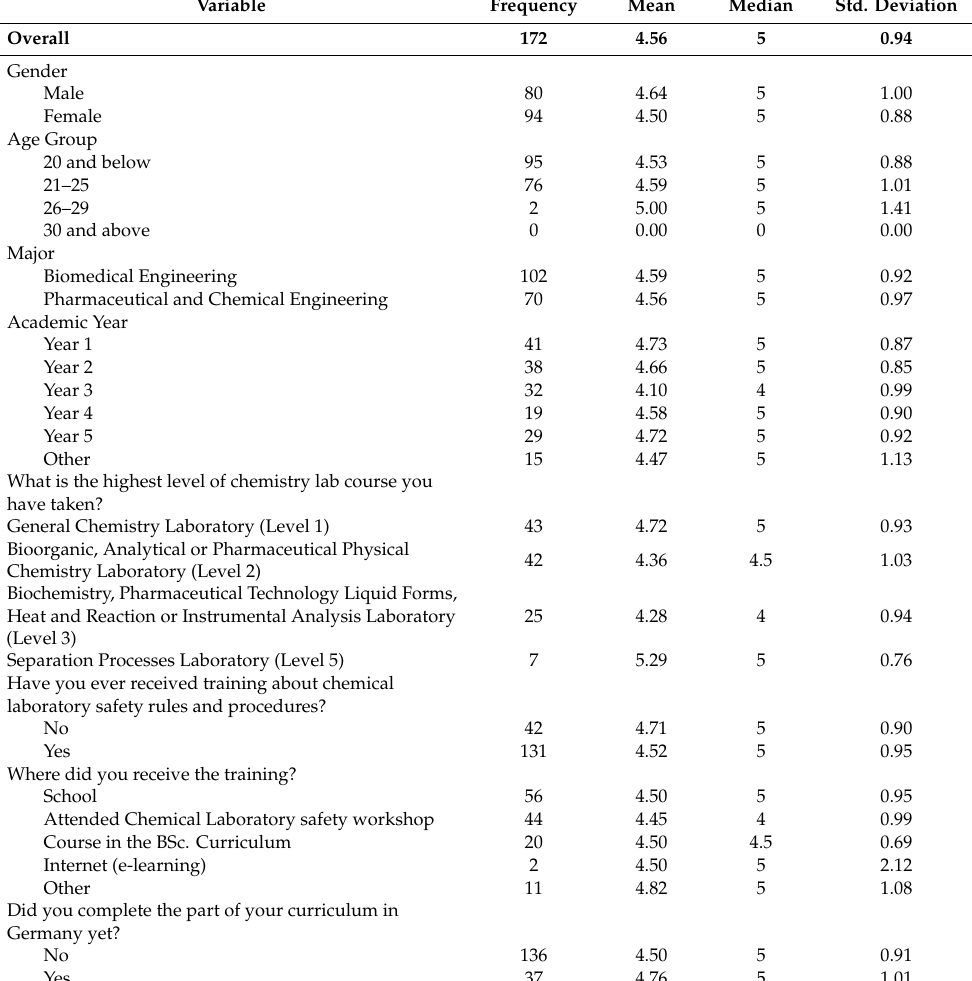
Table 4. Descriptive statistics for the practice scores by selected